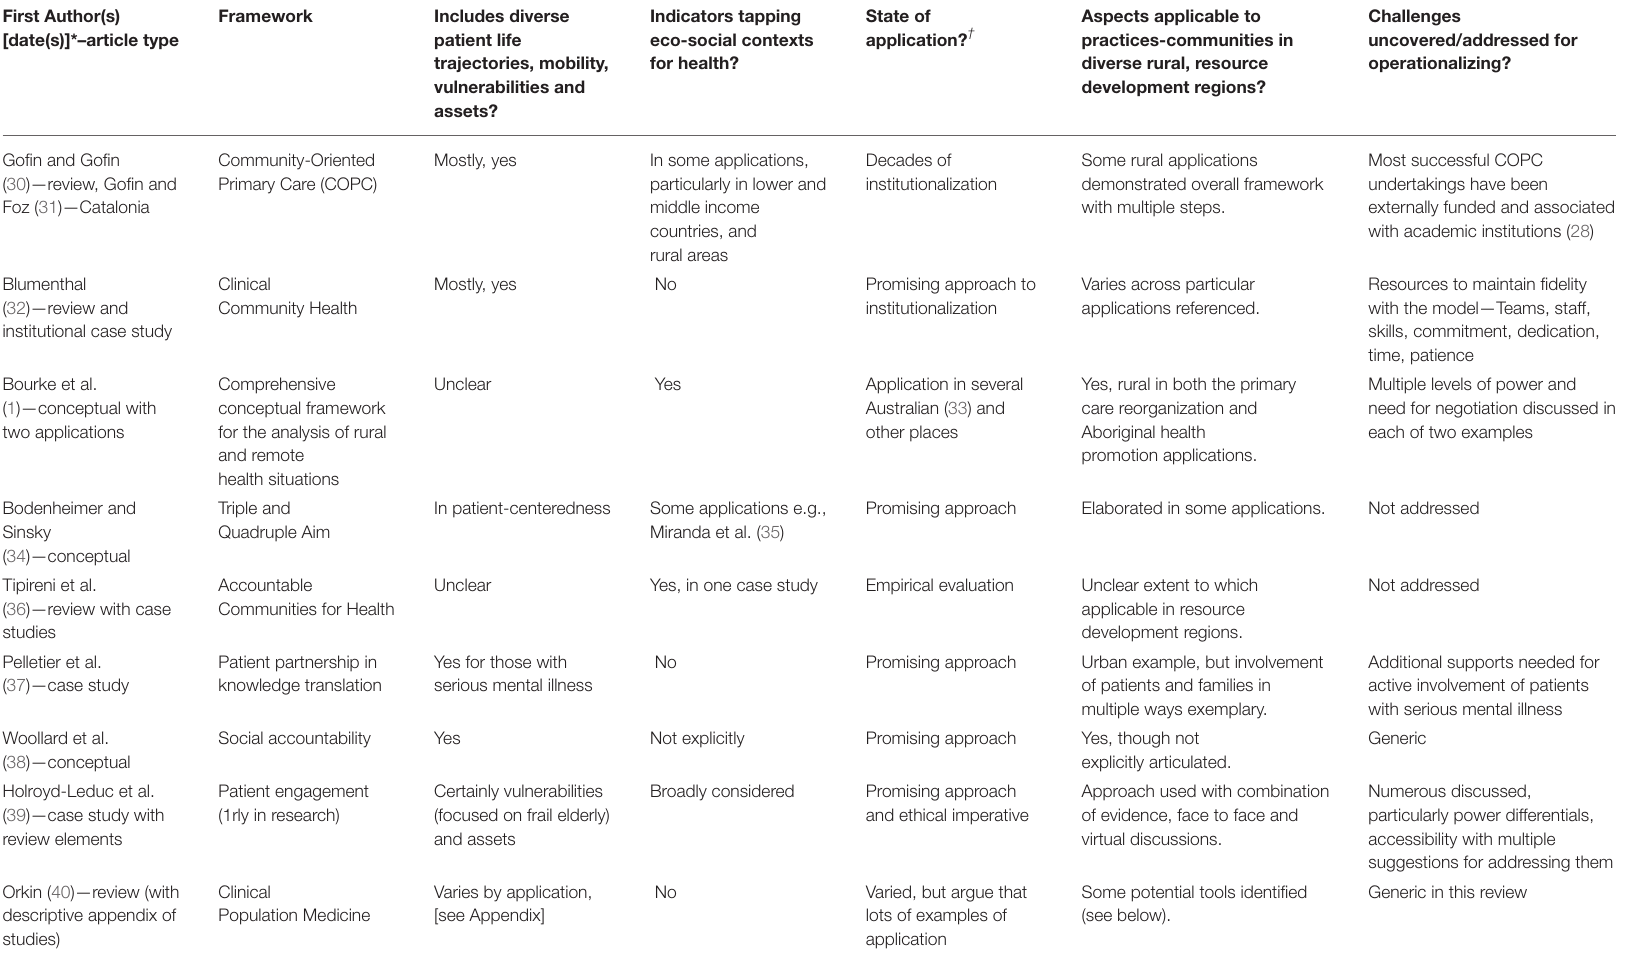
TABLE 1 | Assessment of potentially most relevant frameworks in relation to reflective